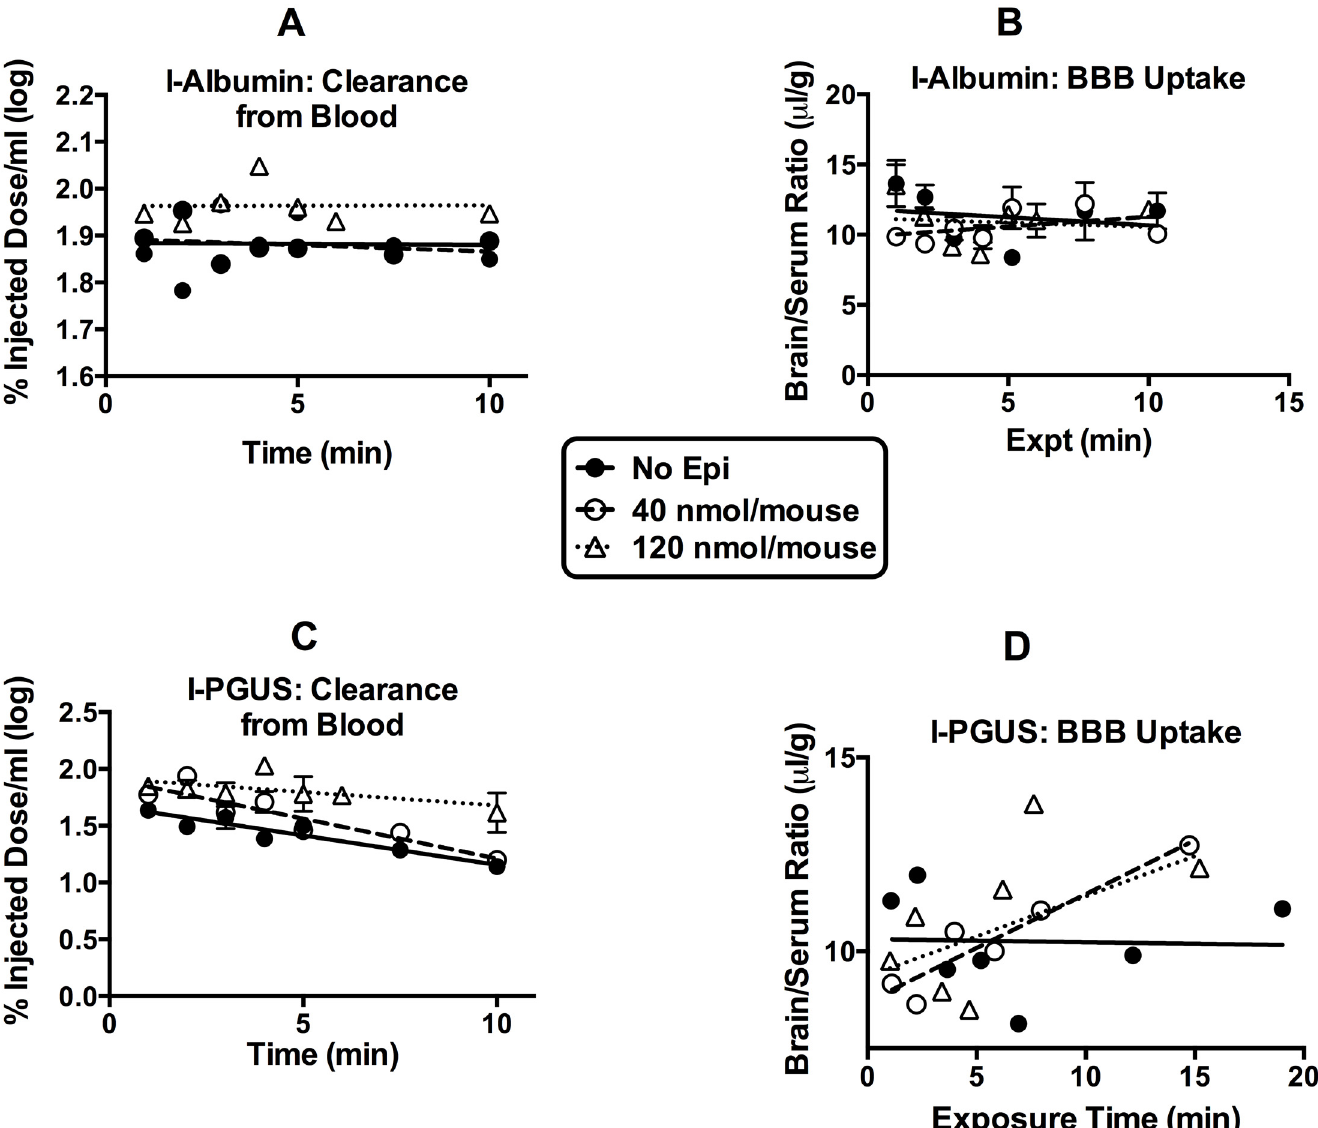
Fig 1. Blood-brain barrier disruption and brain pharmacokinetics of PGUS at two doses of epinephrine. (A) shows that the 120 nmol/mouse dose of epinephrine decreased the vascular space of I-Alb. (B) shows that neither dose disrupted the BBB. (C) shows that both doses reduced vascular space of I-PGUS and that the 120 nmol/mouse dose also slowed clearance from blood. (D) shows that I-PGUS did not cross the BBB, but that both doses of epinephrine induced transport of I-PGUS across the BBB. n = 7/group.